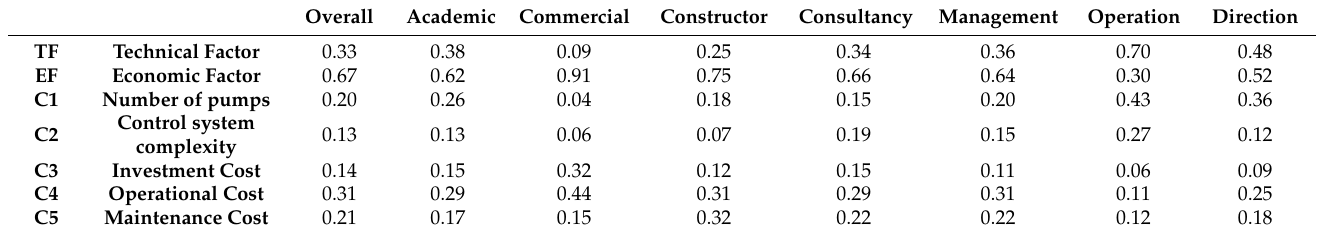
Table 6. Overall priority and priority of every criterion for every expert